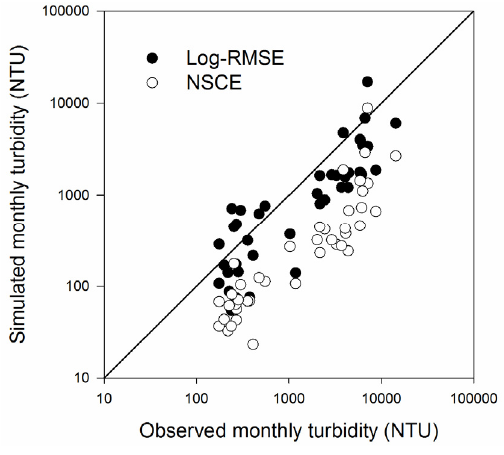
Figure 12. Comparison between model-simulated and observed monthly average turbidity in GRD by using parameters calibrated by two types of objective